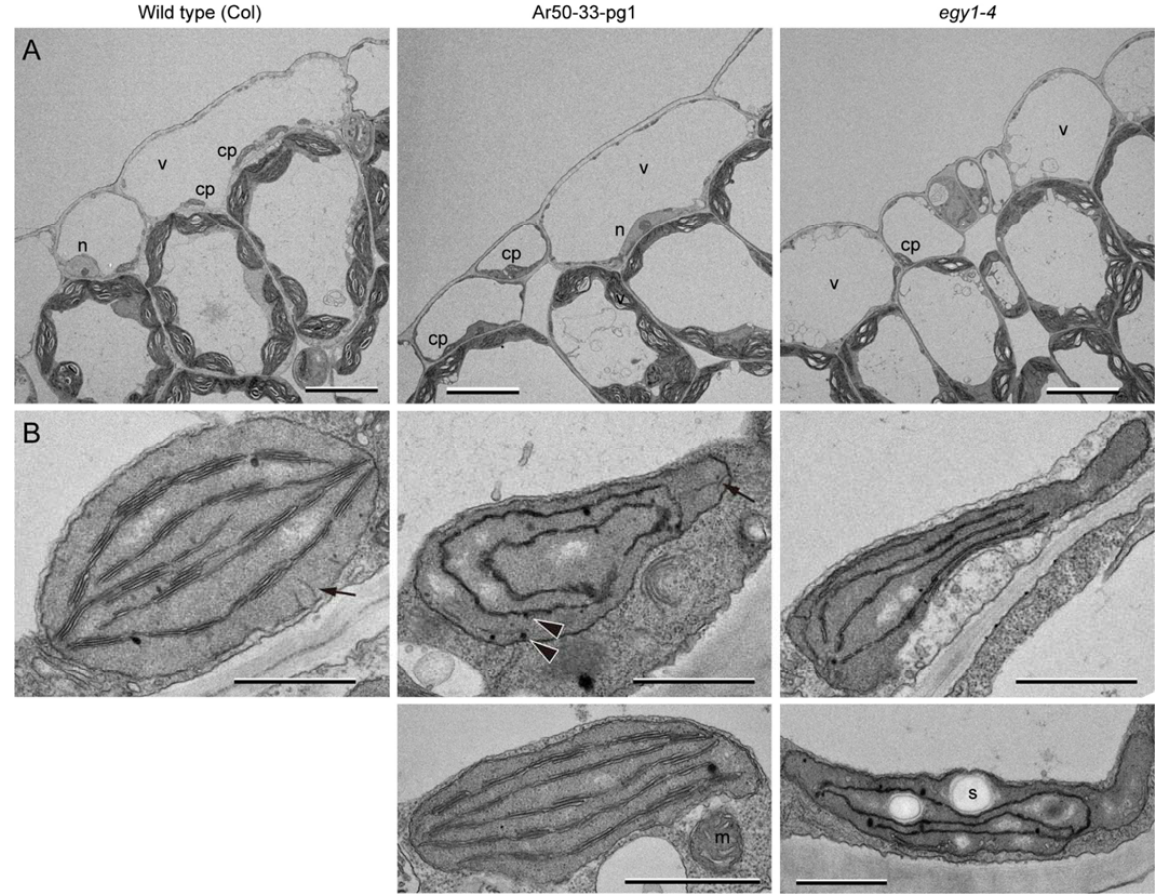
Figure 8. TEM analysis of pavement cells in the expanding wild-type and mutant leaves. Primary leaves of 10-day-old wild-type (Col), Ar50-33-pg1, and egy1-4 plants were analyzed. ( A ) Pavement cells. ( B ) Pavement cell chloroplasts. Arrows and arrowheads indicate tubular structures extending from the inner envelope and plastoglobules, respectively. See also Figure S7. Abbreviations: cp, chloroplast; n, nucleus; s, starch grain; v, vacuole. Bar = 10 µm ( A ) and 1 µm ( B ).